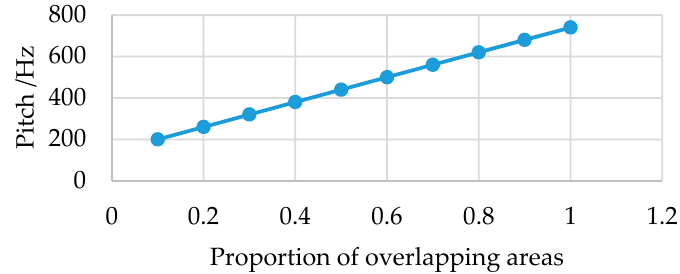
Figure 10. The relationship between the proportion of overlapping areas and instrument pitch.